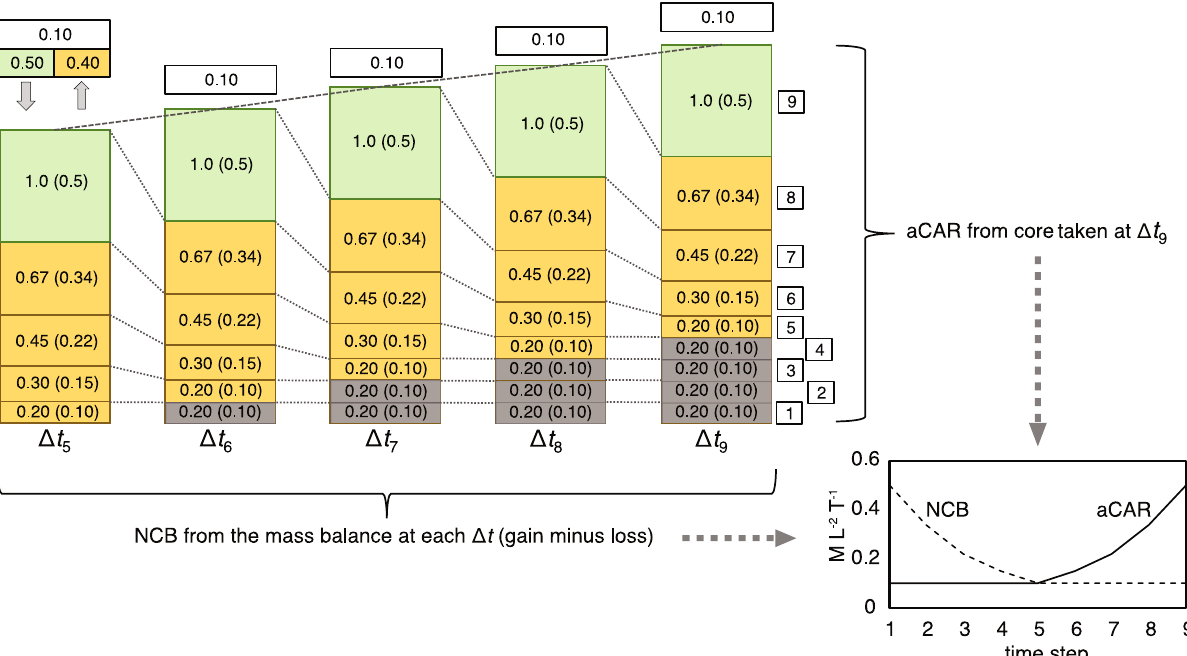
Figure 2. Scenario 2 showing a dynamic acrotelm of constant mass, and a steadily-thickening catotelm (blue- grey shading representing waterlogged peat). Layers 1–4 become submerged by the rising water table, and by Δ t 9 the acrotelm comprises layers